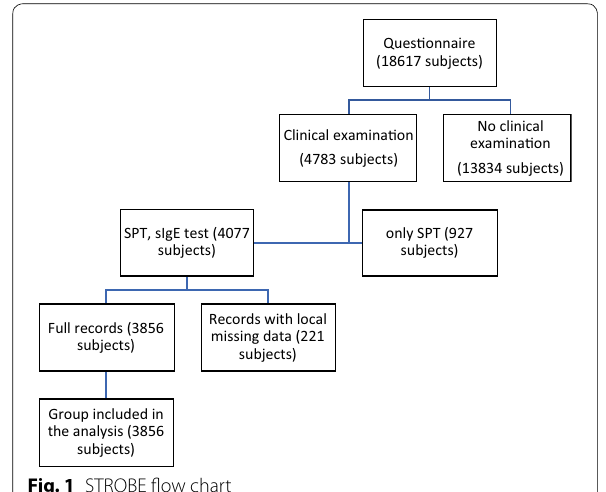
Fig. 1 STROBE flow